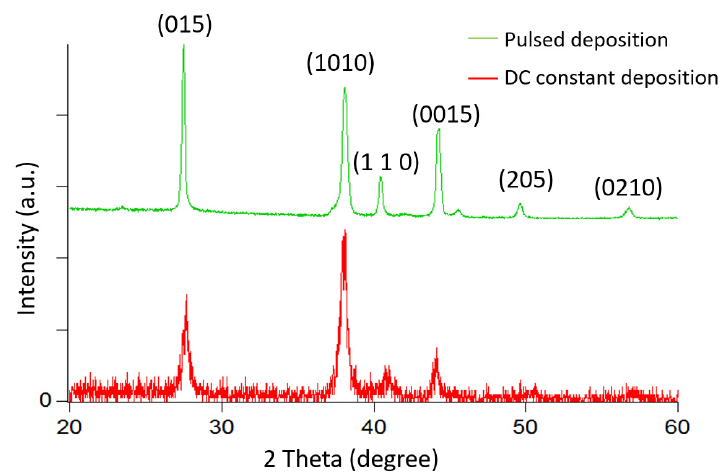
Figure 19. XRD patterns of the Sb 2 Te 3 films synthesized by constant and pulsed deposition at − 144 mV.